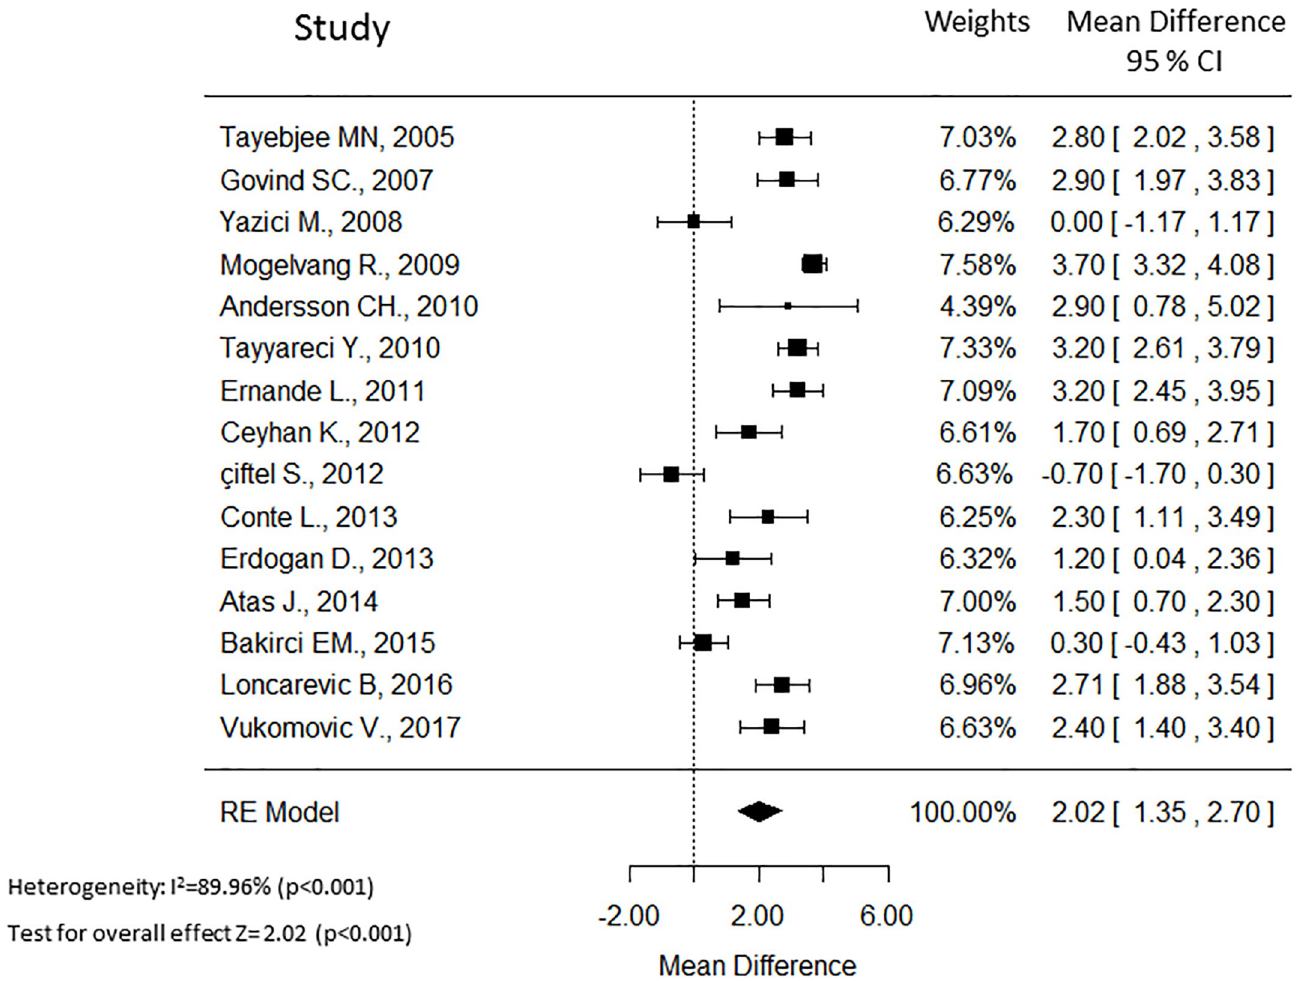
Fig 2. The Forest plot of the weighted mean difference (WMD) of E/e’ ratio with 95% C.I. of the included studies that compared averaged E/e’ between patients with and without diabetes. A positive value signifies that E/e’ is higher in patients with diabetes.